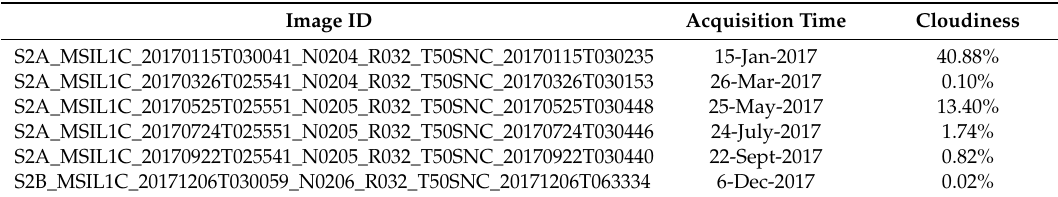
Table 1. Remote sensing image data used for urban vegetation estimation.